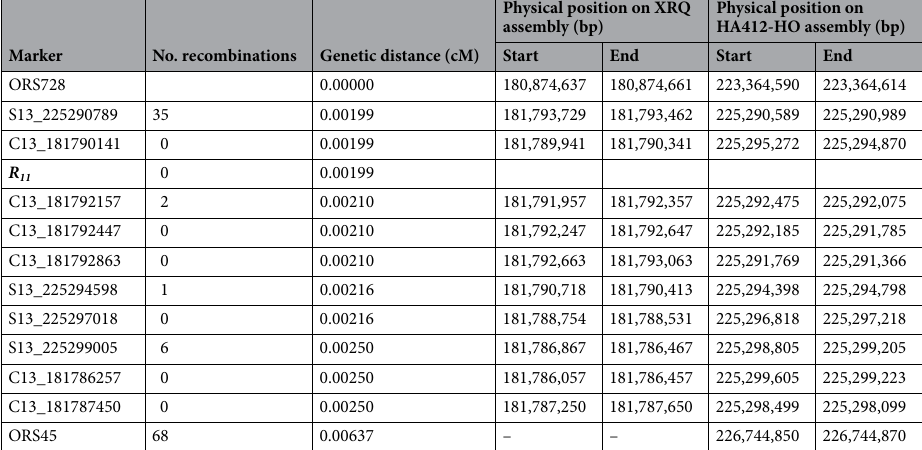
Table 2. Genetic and physical positions of markers linked to R 11 on the fine map of chromosome 13.